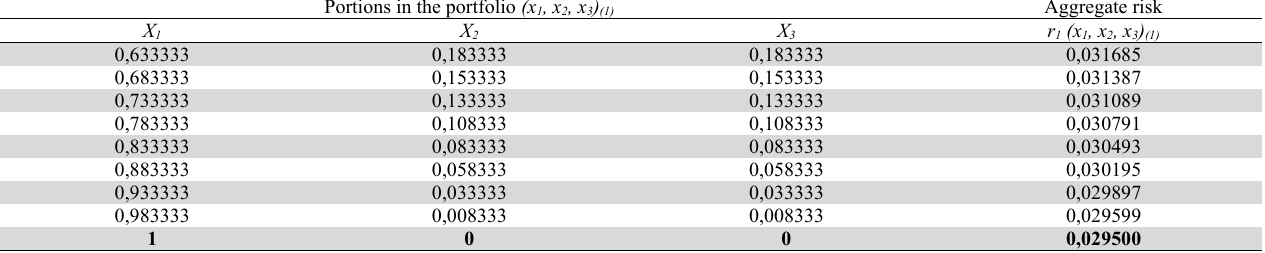
Fragment of the decision table in forming the optimal structure of the investment program (strategy 1) Portions in the portfolio (x 1 , x 2 , х 3 ) (1)